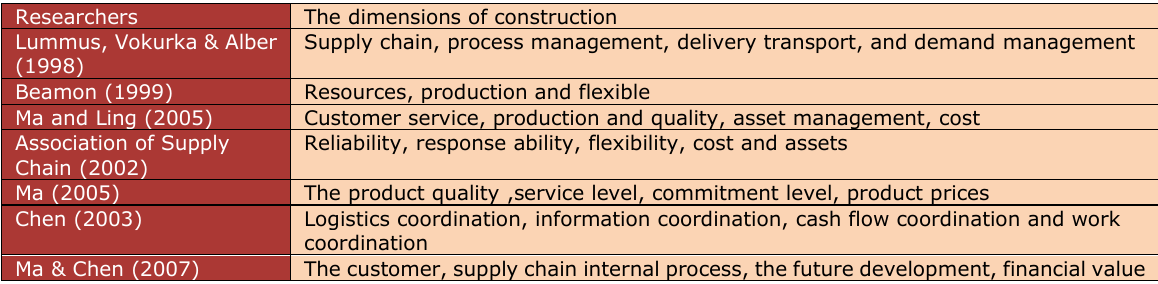
Table 1. The dimensions of